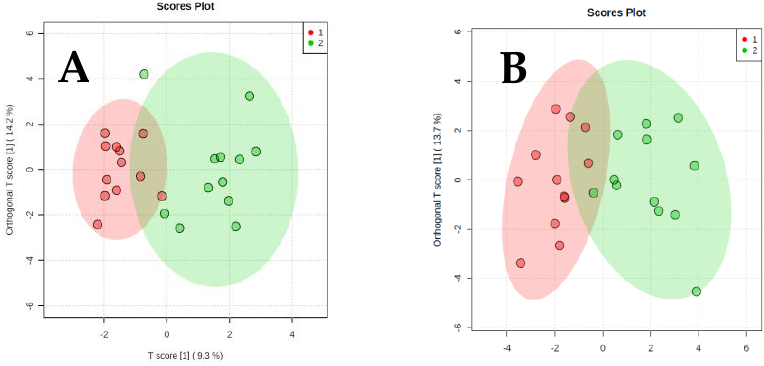
Figure 4. Orthogonal projections to latent structures discriminant analysis. ( A ) Pre-cachectic patients and cachectic patients. Urinary Metabolites only. ( B ) Pre-cachectic patients and cachectic patients. Urinary metabolites and information on fat and muscle area from CT scans.